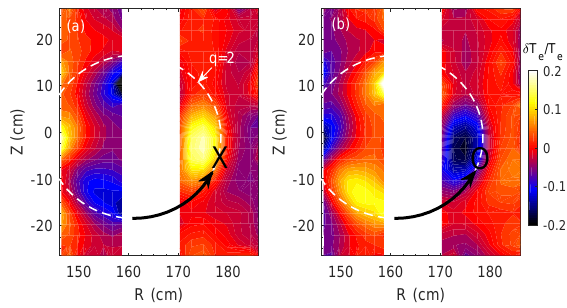
Figure 7. 2D mode structure of the m / n = 2 / 1 tearing mode mea- sured by ECEI. The white dashed curves denote the q = 2 surface, and the X-point and O-point of the island are indicated with the black X and O marks, respectively.